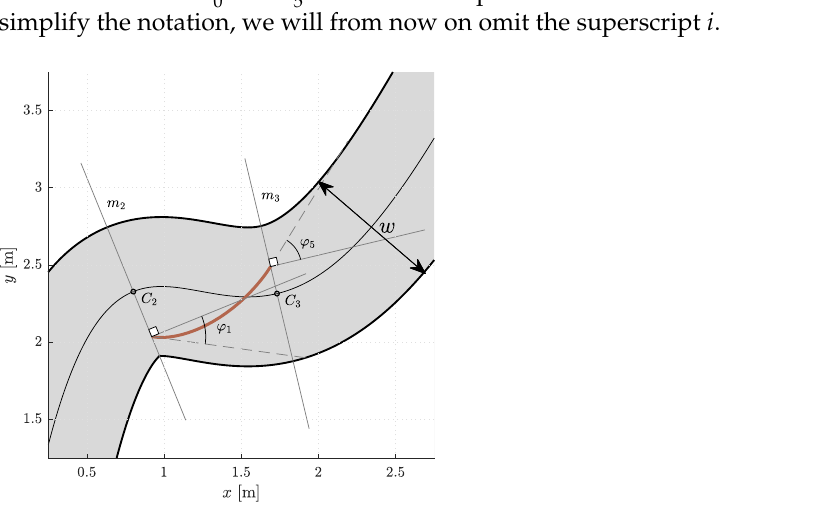
Figure 4. A segment with a Bézier curve. ϕ 1 and ϕ 5 are measured from the line perpendicular to m i .